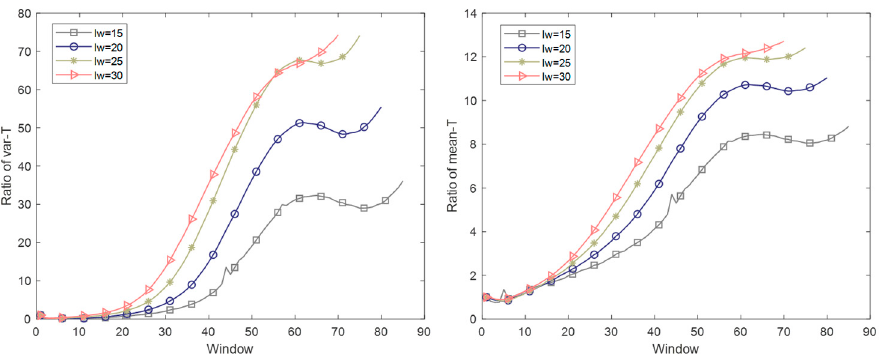
Figure 9. The variation trend of the score matrix with window length from 15 to 30.